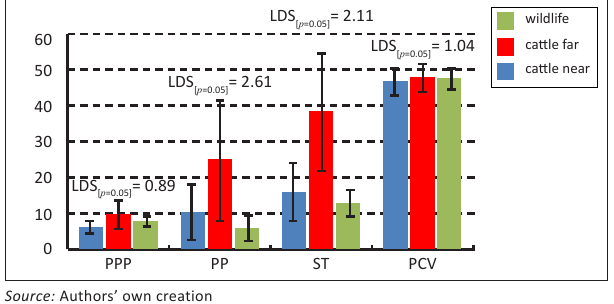
FIGURE 3: Development of packed cell volume represented as mean for (a) high virulence strain, (b) moderate virulence strain and (c) low virulence strain. Mean control values are represented as the first point for the three categories.